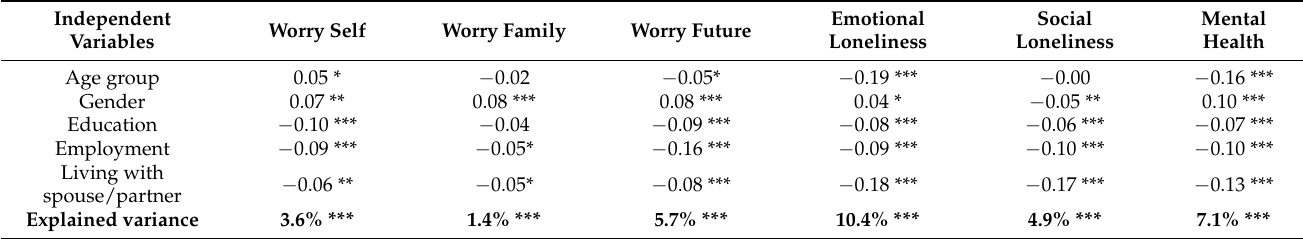
Table 4. Standardized β weights of adjusted associations between sociodemographic factors and worrying, loneliness and mental health among participants without infection ( n =